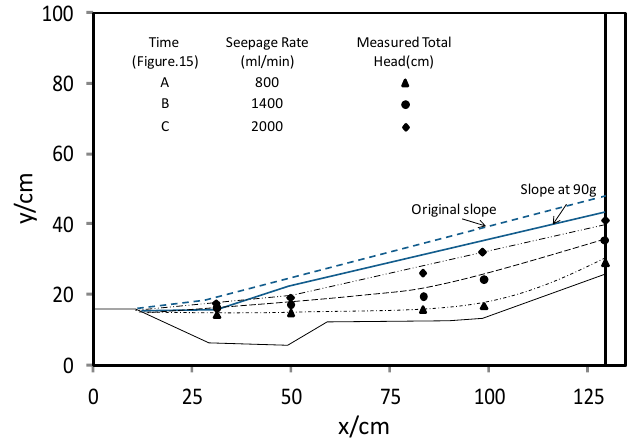
Figure 15. Variations of pore water pressure with time in model slope.